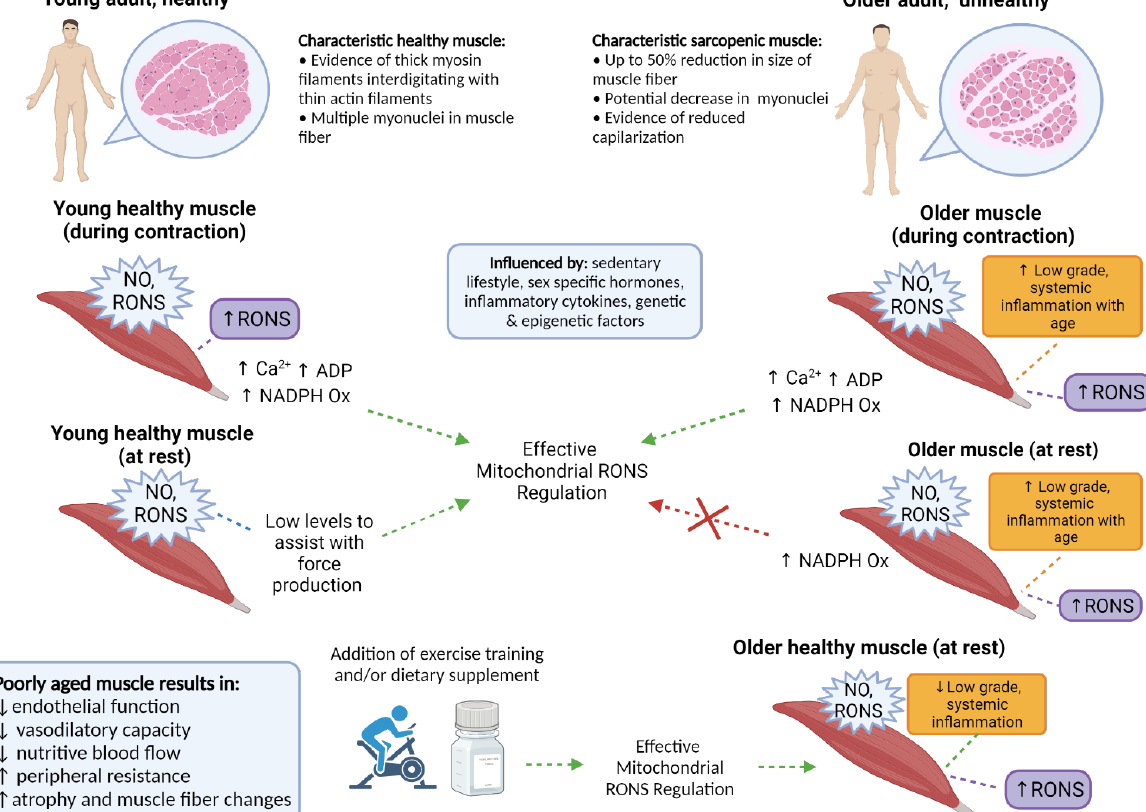
Figure 1. Comparison of characteristically healthy and sarcopenic muscle, in young and older adults. Essential RONS signaling is apparent in young healthy muscle during contraction but becomes greater with advancing age at rest. Effective and proportionate regulation of RONS could be influenced by several modifiable and non-modifiable factors, with the capacity for self-regulation becoming less efficient with age. The lower half of the figure indicates the consequences of poorly aged muscle, with specific interventions supporting healthy muscle aging and RONS regulation, even in the presence of increased RONS production. Created with BioRender.com.